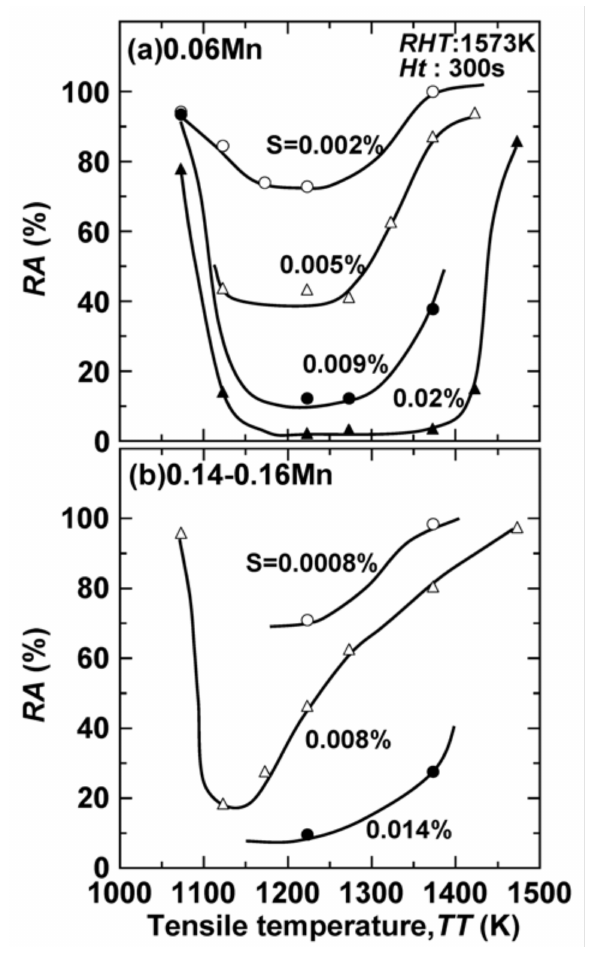
Figure 26. Influence of tensile temperature and S content on the reduction of area (RA) after reheating at 1573 K for a low manganese mild steel ( RHT = reheating temperature; Ht = heating time). Reprinted from ref.